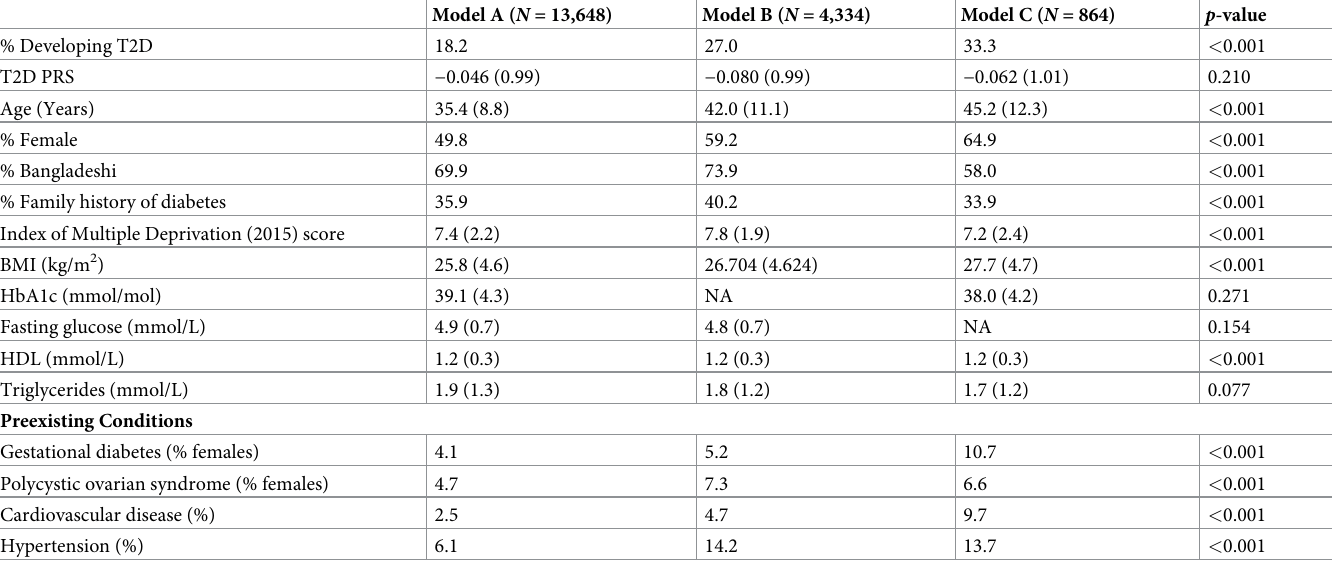
Table 1. Characteristics of participants included in analysis with each QDiabetes